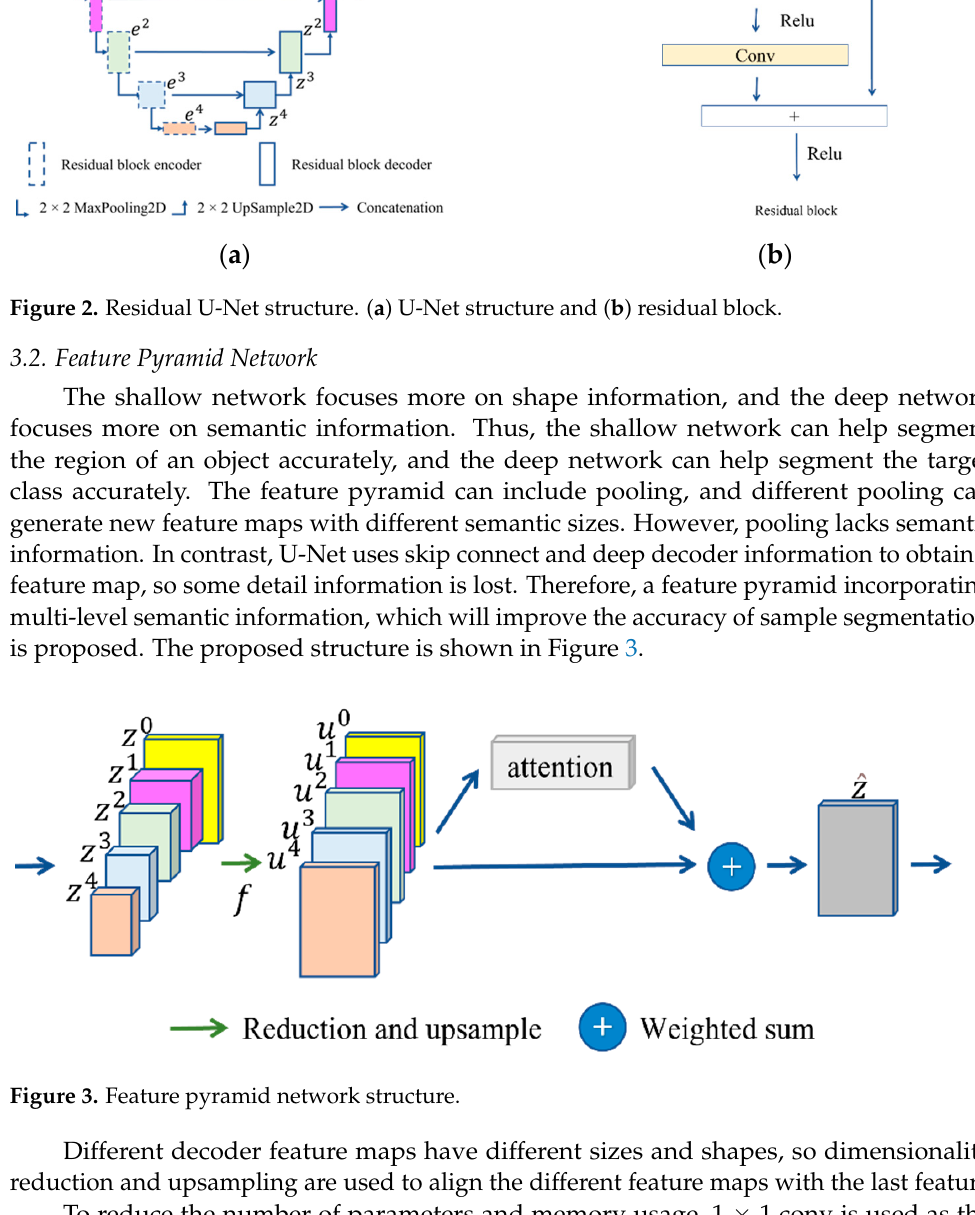
Figure 3. Feature pyramid network structure.